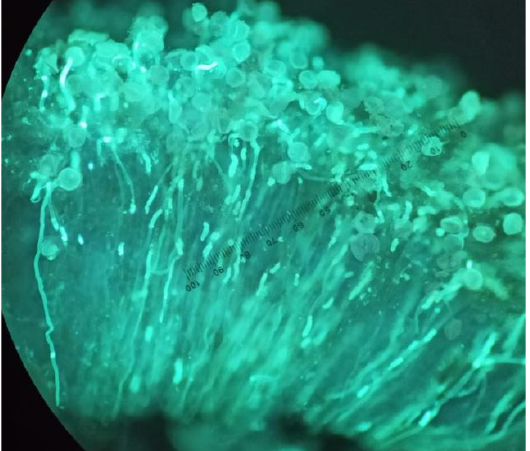
Figure 1. Adhesion of pollen grains and growth of pollen tube on watermelon stigma and style. Capture under epifluorescence microscopy (Nikon E600, ×20).